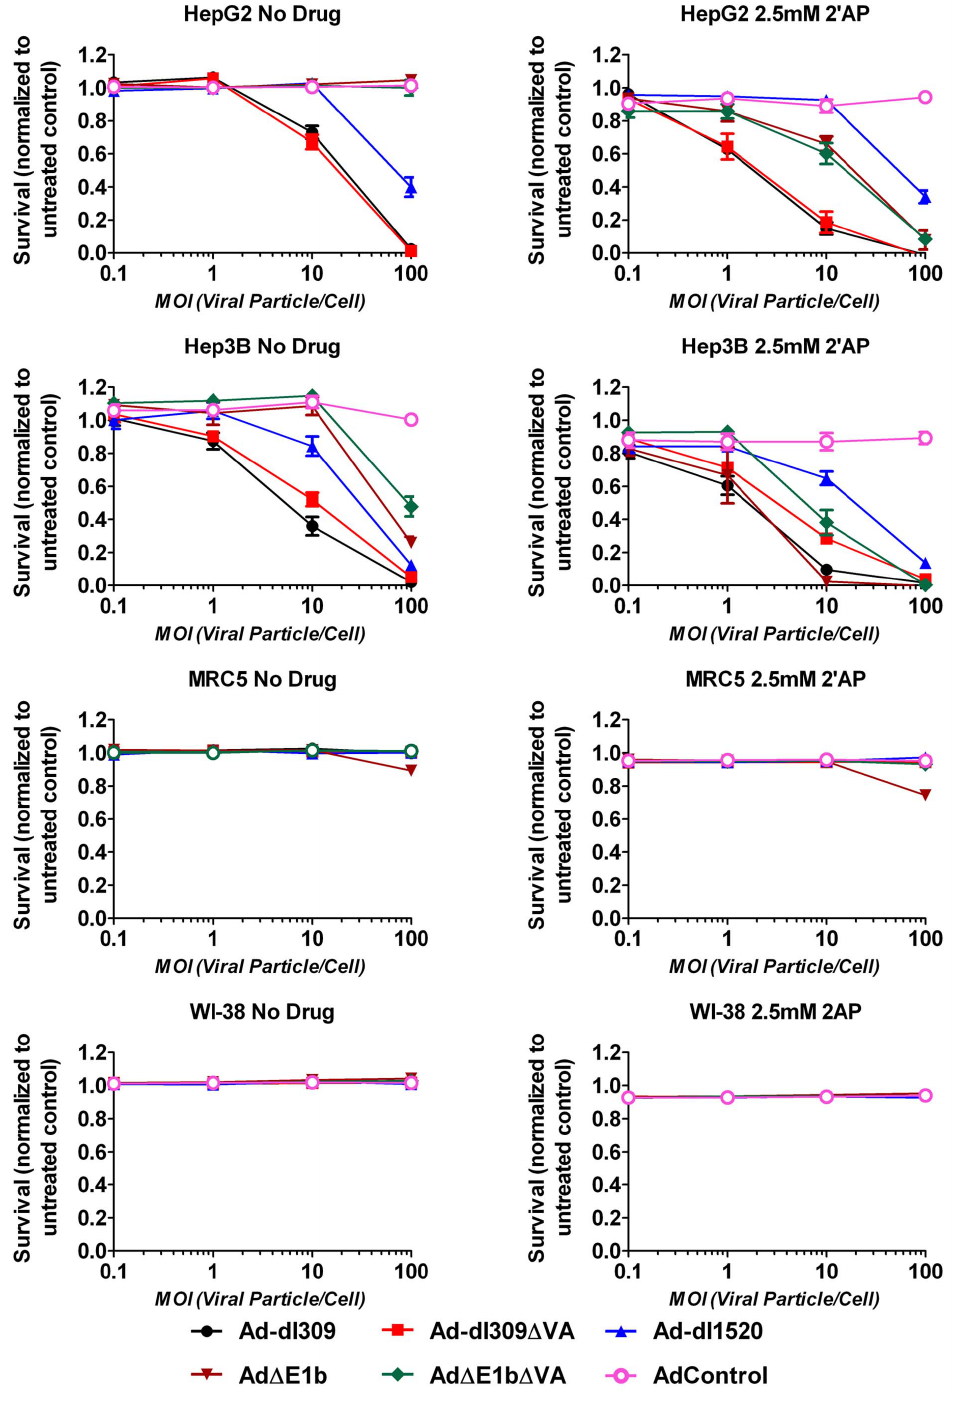
Figure 6. 2 9 AP increased virus-mediated death of HepG2 and Hep3B HCC cells but not normal fibroblasts. HepG2 and Hep3B HCC cells as well as MRC5 and WI-38 normal cells were infected at the indicated MOIs and then incubated with or without 2.5 mM 2 9 AP. Six days post-infection, cell survival was measured by Alamar Blue fluorescence measurements and normalized to uninfected controls. Error bars correspond to + / 2 SD of quadruplicates. doi:10.1371/journal.pone.0065222.g006 cell lines were resistant to killing by all the replicating viruses, suggesting that the 2 9 AP increase in virus-mediated HCC cell death could be dependent on pathways specifically deregulated in HCC cells.